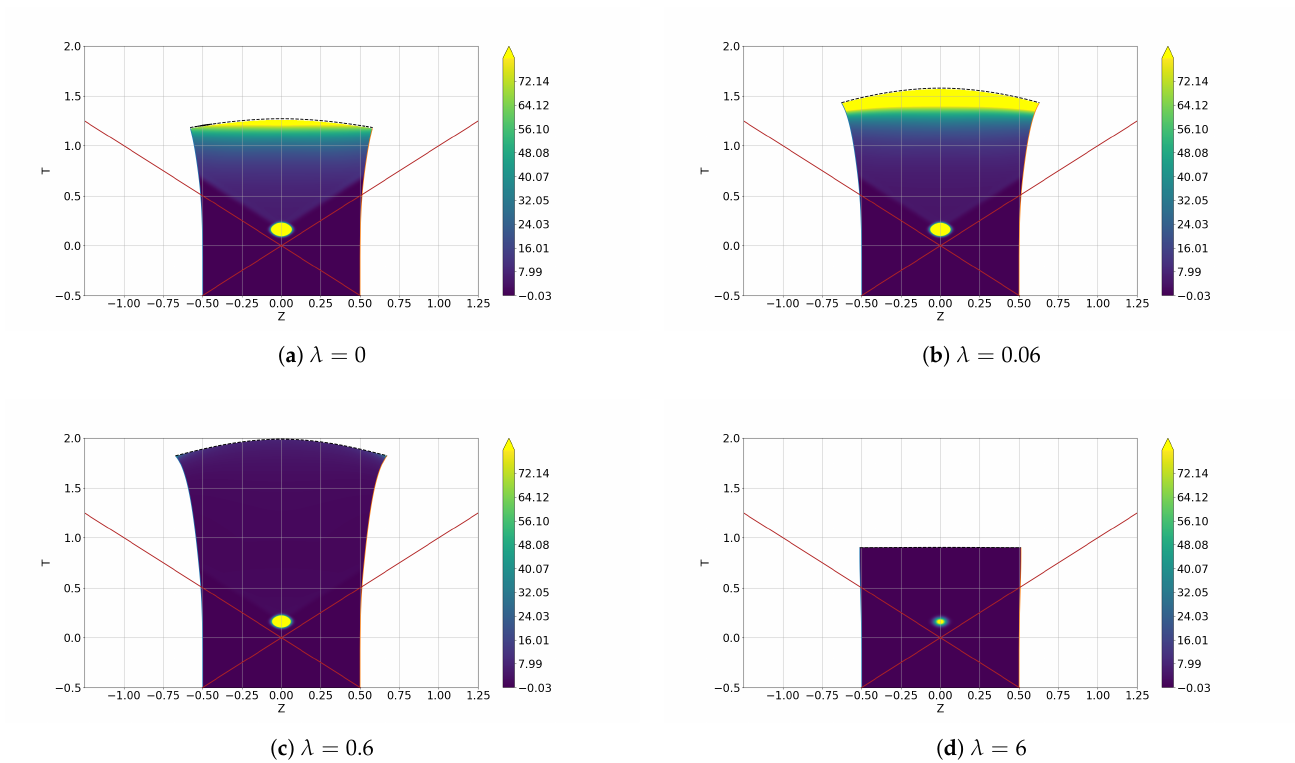
Figure 10. Penrose–Carter contour plots of the Weyl invariant I for the case of colliding waves with varying λ